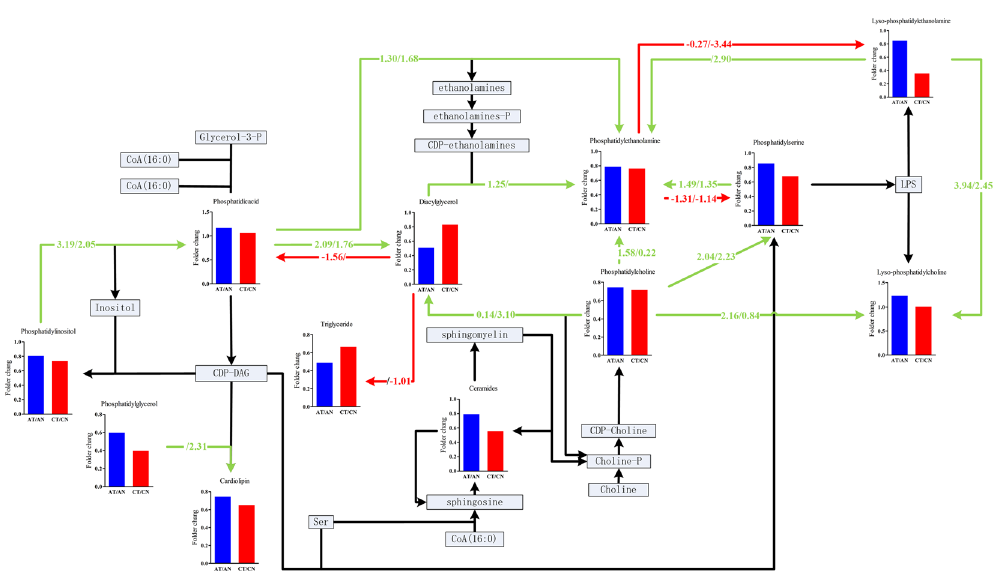
Figure 5. Lipid pathways that were involved in the LVTA models. Fold changes were determined by comparing ratios of the sums of the differential lipid species within a lipid class between LVTA and controls myocardia specimens. The values on each axis denoted Z -scores, calculated by Z = CDF − 1 (1 − P ), where CDF were the cumulative distribution function. P -values were calculated using student’s t -test between LVTA models and controls and determined the weight of each reaction (each axis). Green lines indicated that the amount of product was greater than the reactant; red lines had the opposite meaning. Z -values above slashes were from Model I, while those under slashes were from Model II; Z -values greater than 1.645 suggested that a pathway was